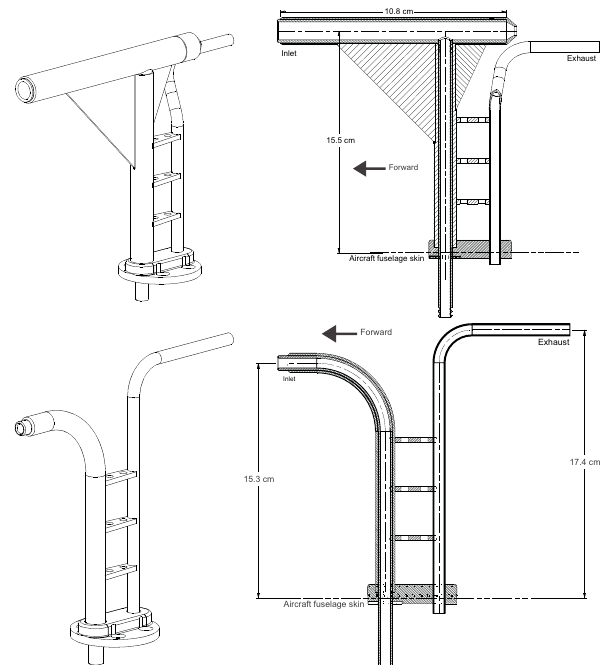
Fig. 3. Two types of NOAA-2 O 3 inlets tested on board the NASA WB-57F aircraft. Upper panel: side-facing inlet with a tubular scoop. Lower panel: simple forward-facing inlet. Drawing is shown to